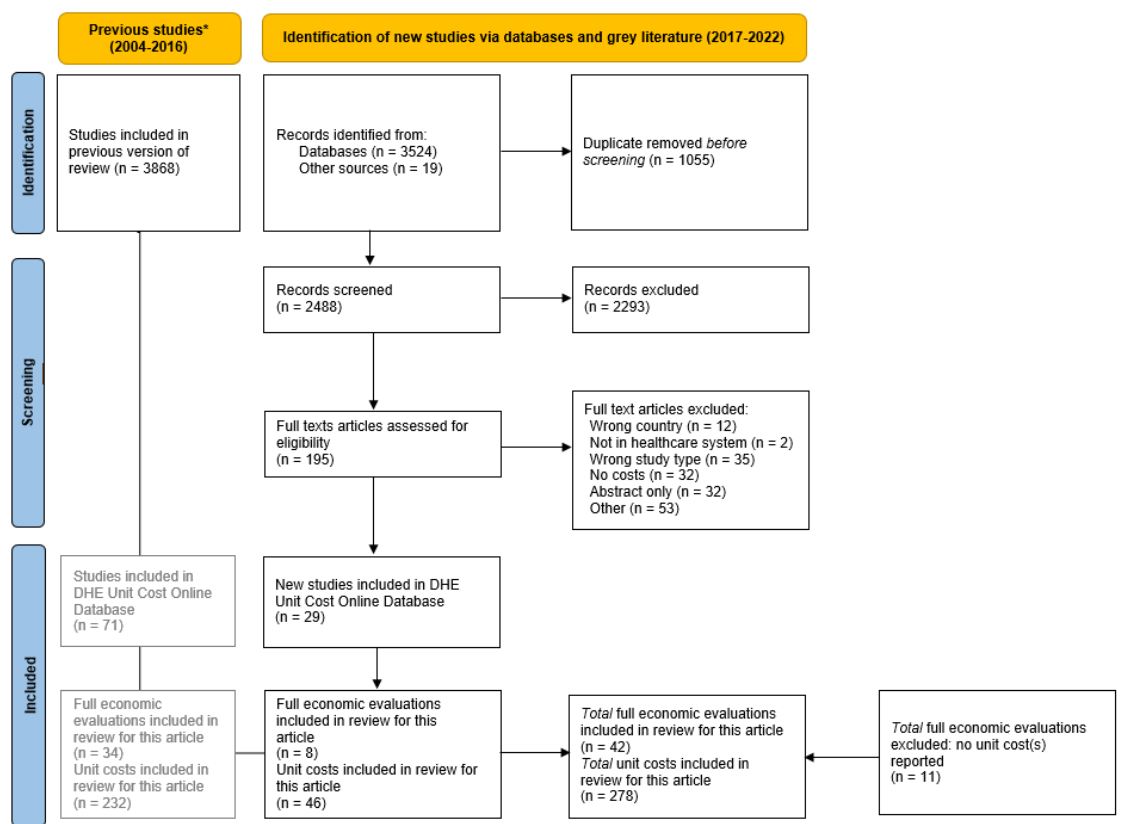
Figure A1. Modified PRISMA flow chart. * Updated information form [4]. Flow chat modified from